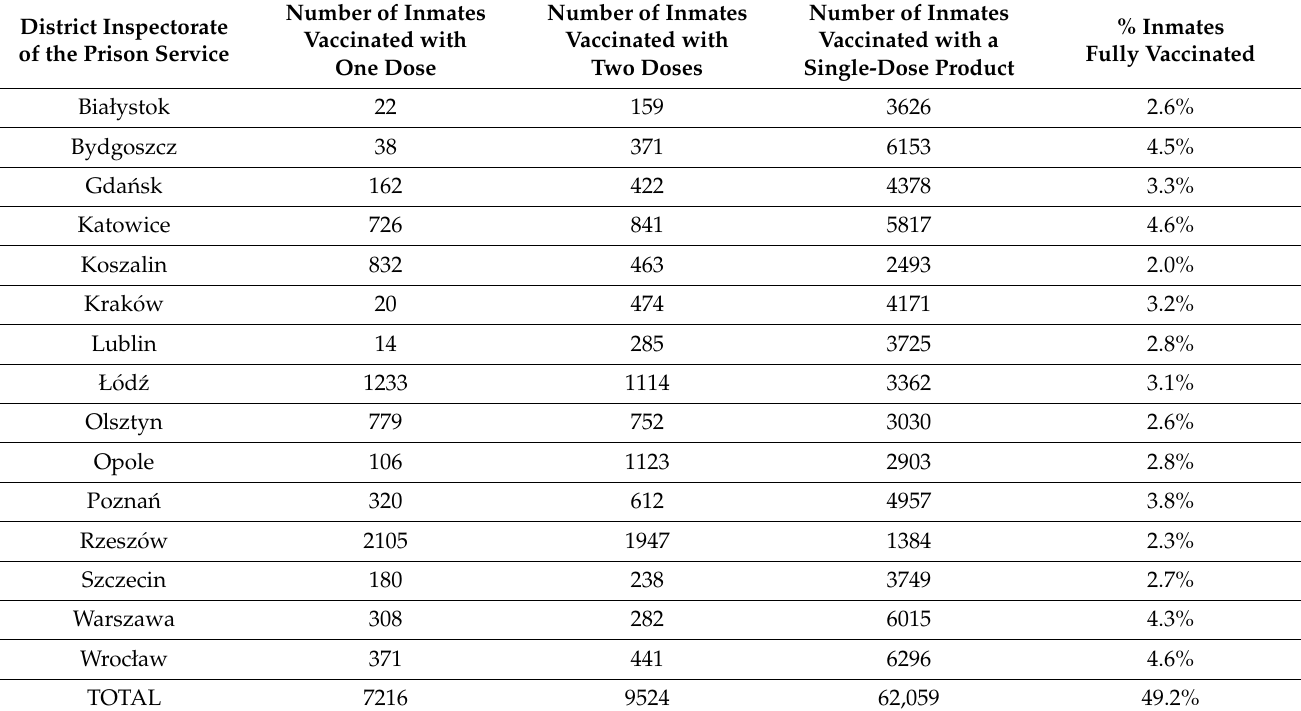
Table 2. Number of people vaccinated in penitentiary institutions in Poland as of 31 December